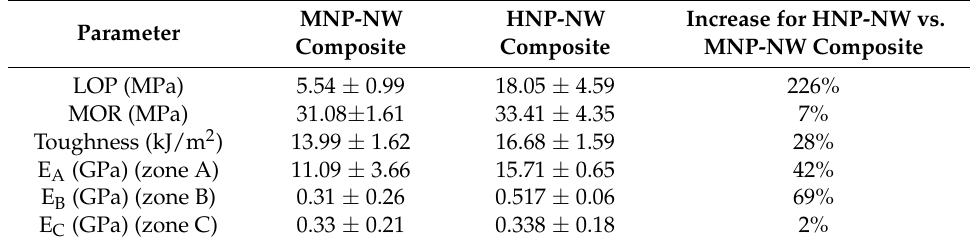
Table 3. Average values and standard deviation of LOP, MOR, E modulus, and toughness, obtained from bending tests and increase of these values for the composites prepared with the HNP-NW fabric with respect to the ones prepared with the MNP-NW fabrics.